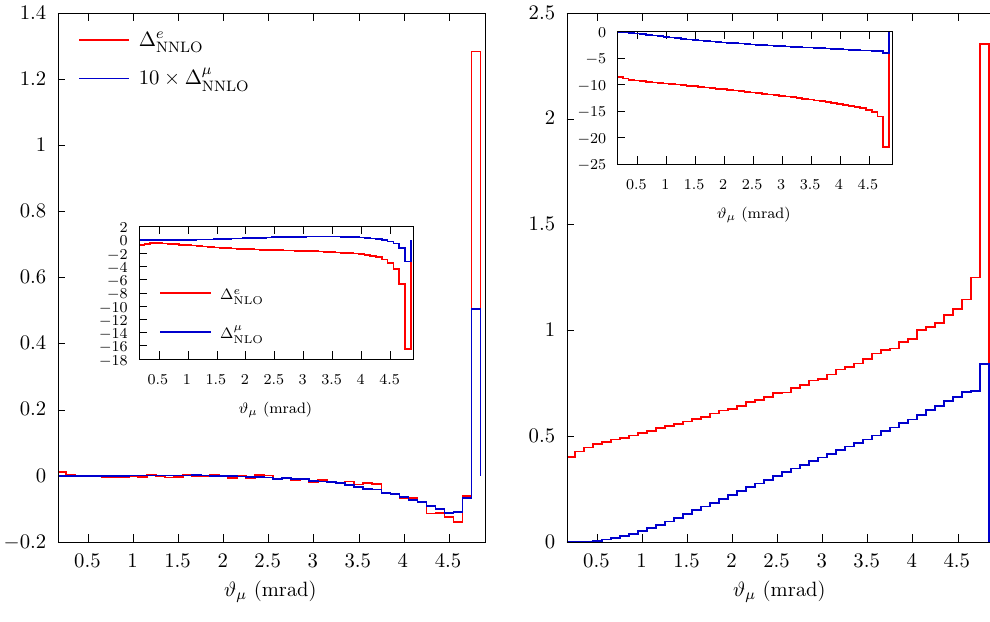
Figure 4 . The same as (cid:12)gure 3 for the muon scattering angle # (cid:22)